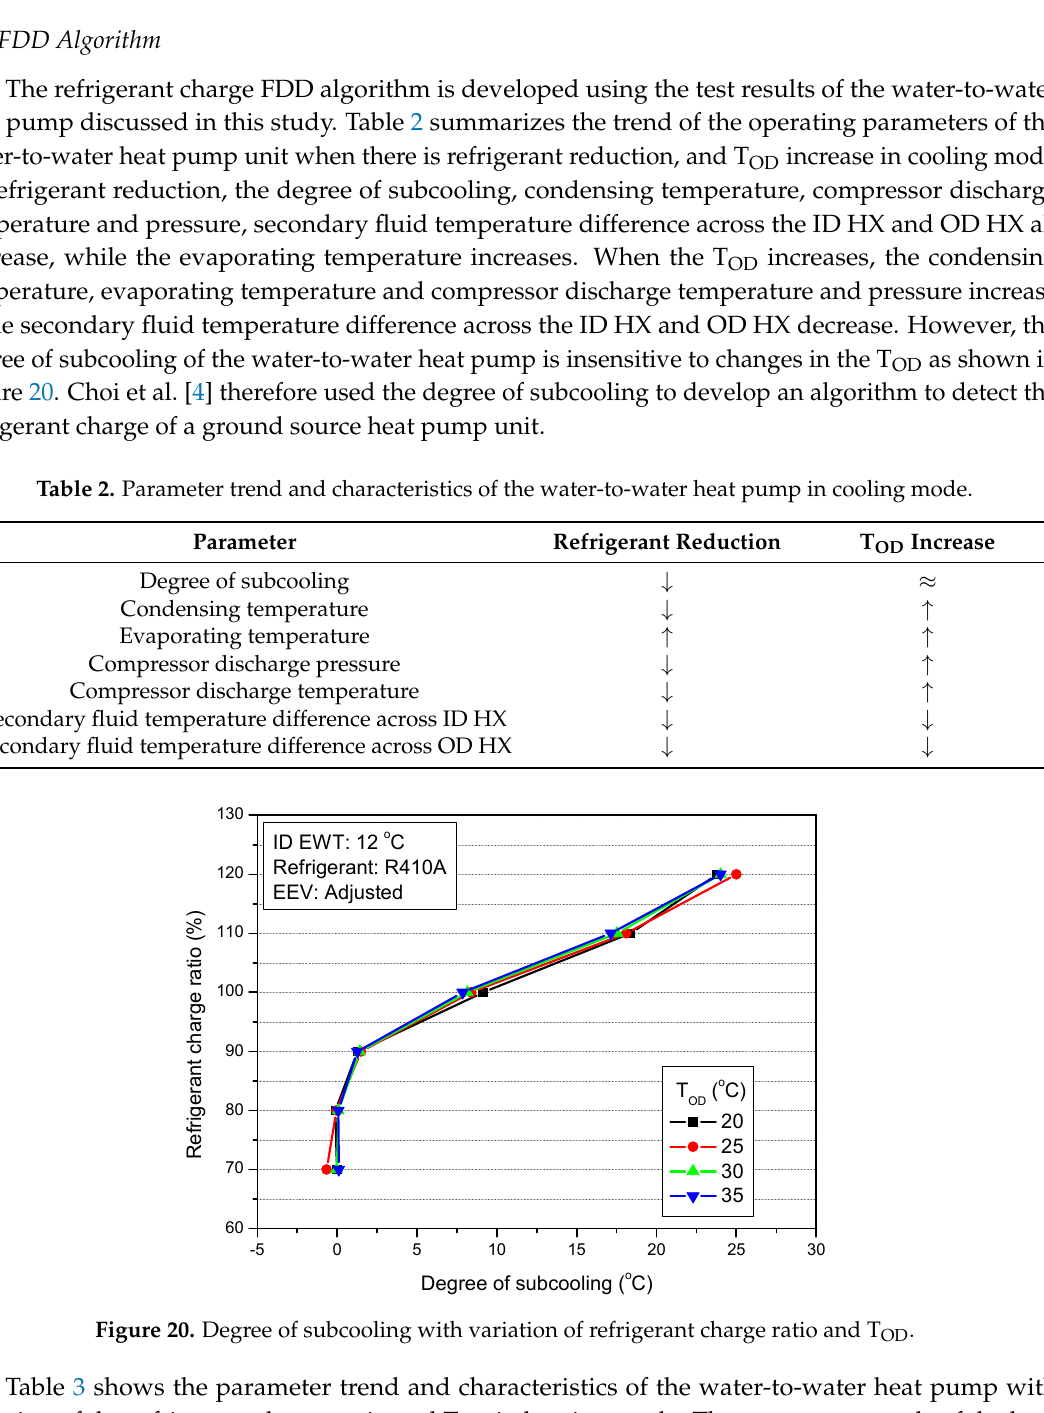
↓ Table 3. Parameter trend and characteristics of the water-to-water heat pump in heating mode. ParameterTitle